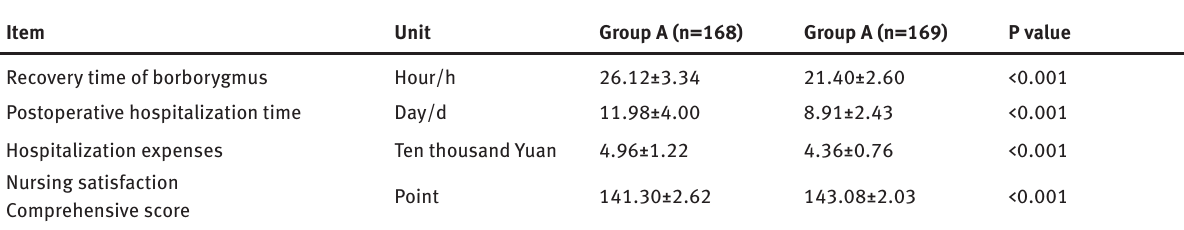
Table 3: The comparison of the recovery time of borborygmus, postoperative hospitalization time, hospitalization expenses, and nursing satisfaction between the two groups